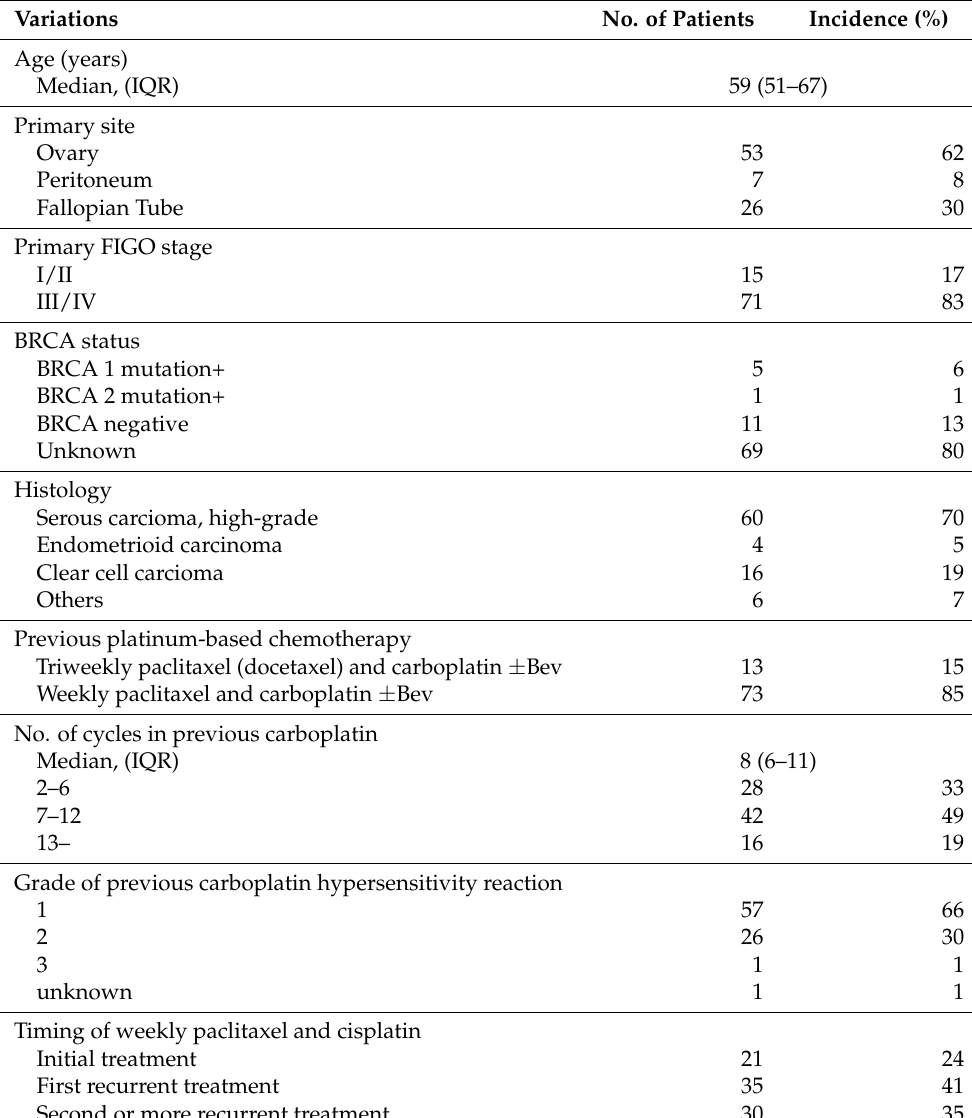
Table 1. Patients